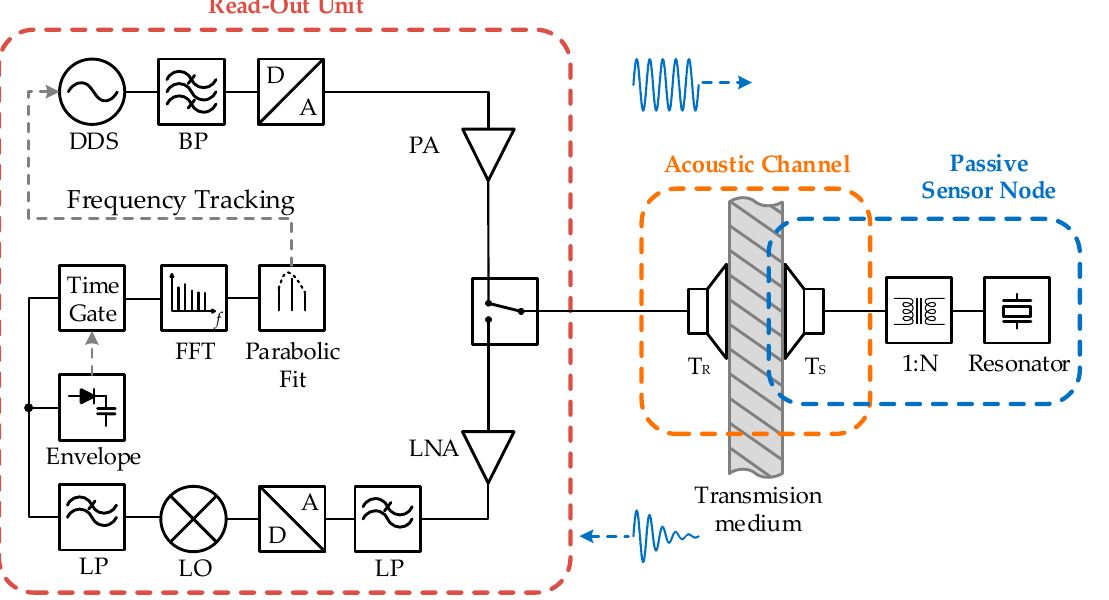
Figure 2. Block diagram of the wireless passive sensor technique using an acoustic channel for the connection between the readout unit and the passive sensor node.